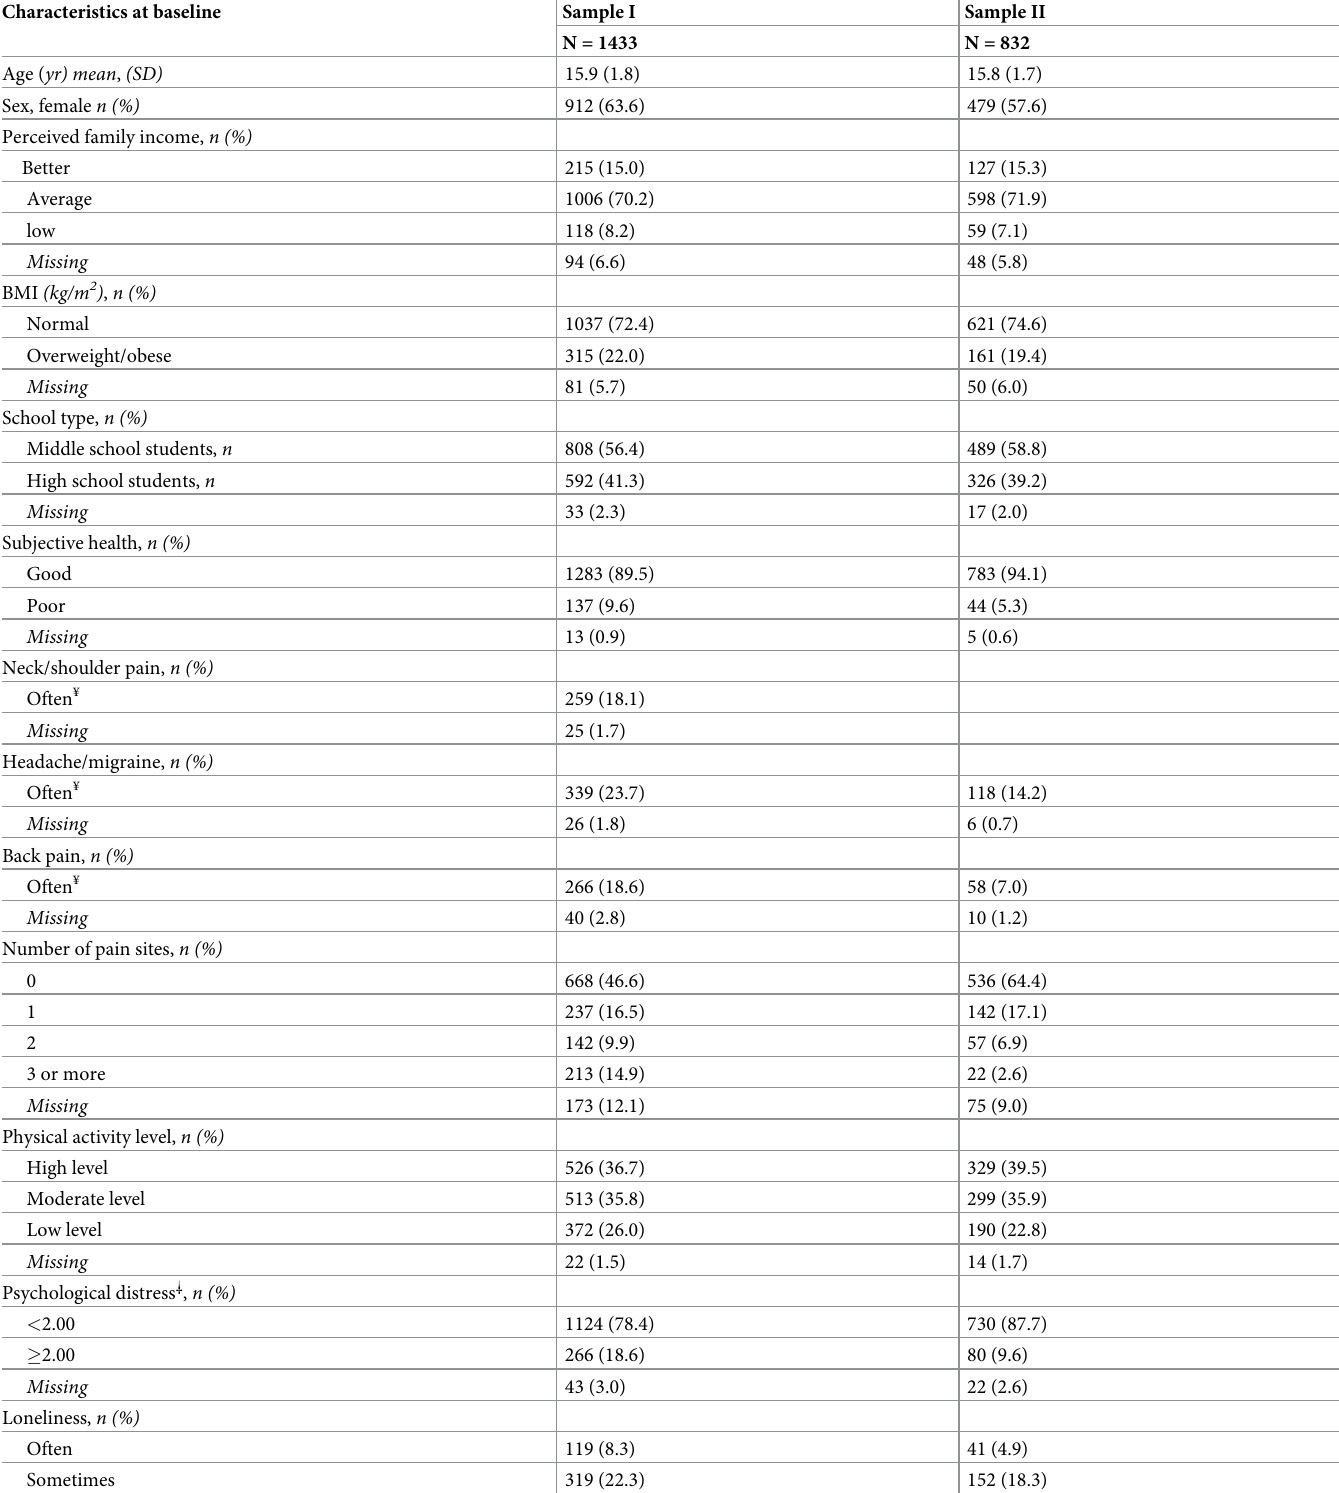
Table 1. Baseline characteristics of study